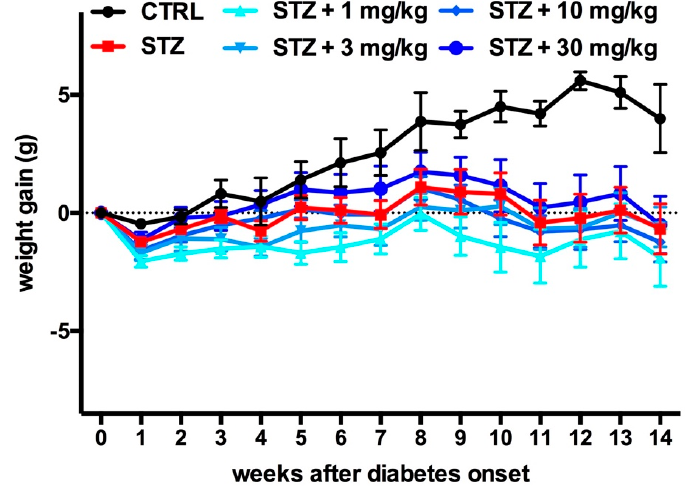
Figure 2. Effect of bilastine on weight gain. Body weight was monitored on a weekly basis, starting from diabetes development (week 0, glycemia ≥ 200 mg/Dl for 90% of diabetic animals) throughout the experimental period and weight gain was estimated. Data are expressed as mean ± S.E.M. ( n = 10/group).